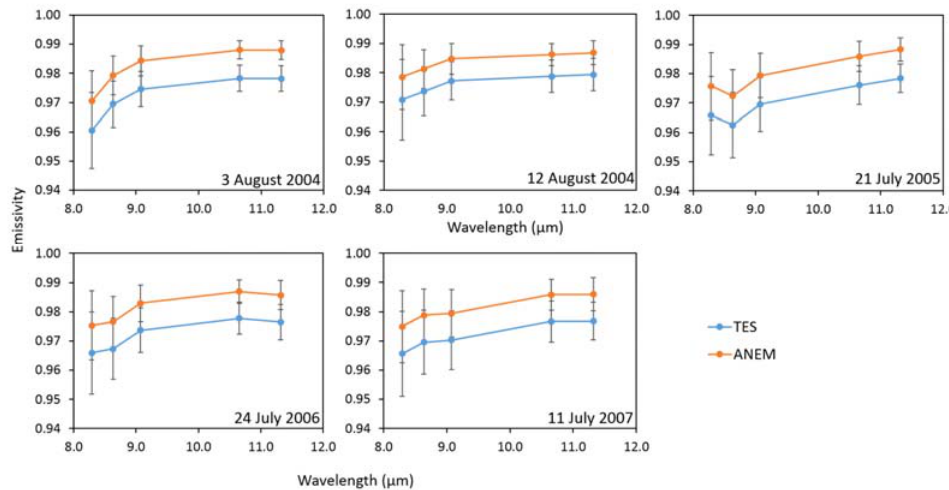
Figure 7. Mean emissivity retrieved with TES and ANEM methods using the pixels classified as water for the five thermal ASTER bands.